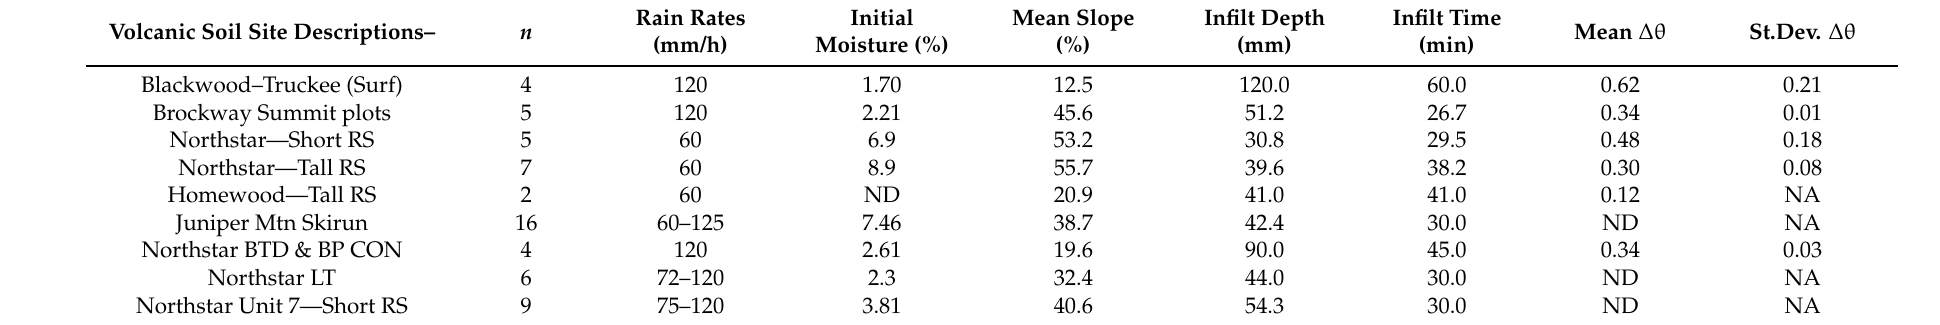
Table 7. Summary of RS plot setting data averages for volcanic soil plots not generating